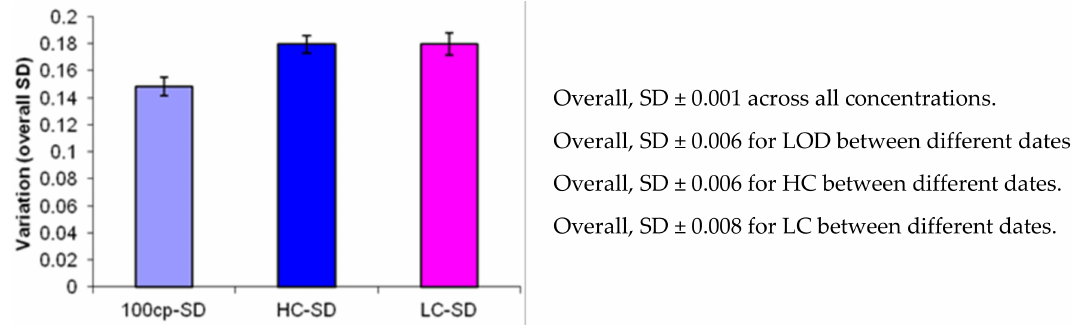
Figure 2. The precision of the LC480 PCR system. The overall variation is summarized from the data of Table S4.0.1; Table S4.0.2; Table S4.0.3; Table S4.1.1; Table S4.1.2; Table S4.1.3; Table S4.2.1; Table